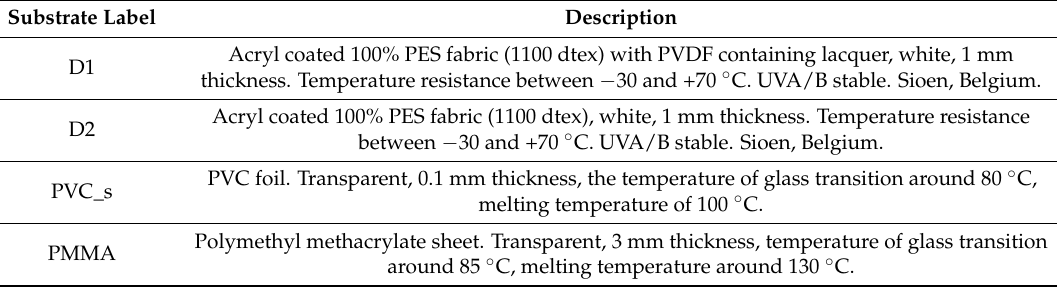
Table 1. Main characteristics of